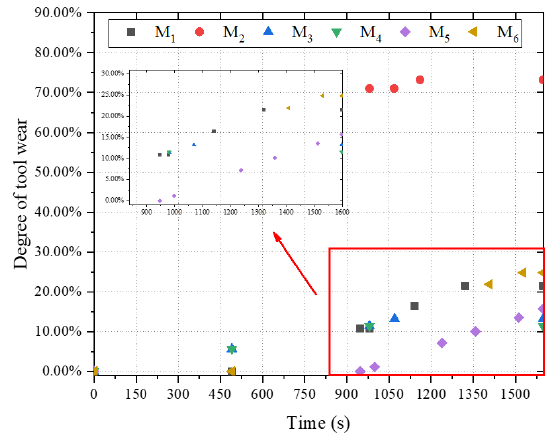
Figure 25. Scatter chart of tool wear.